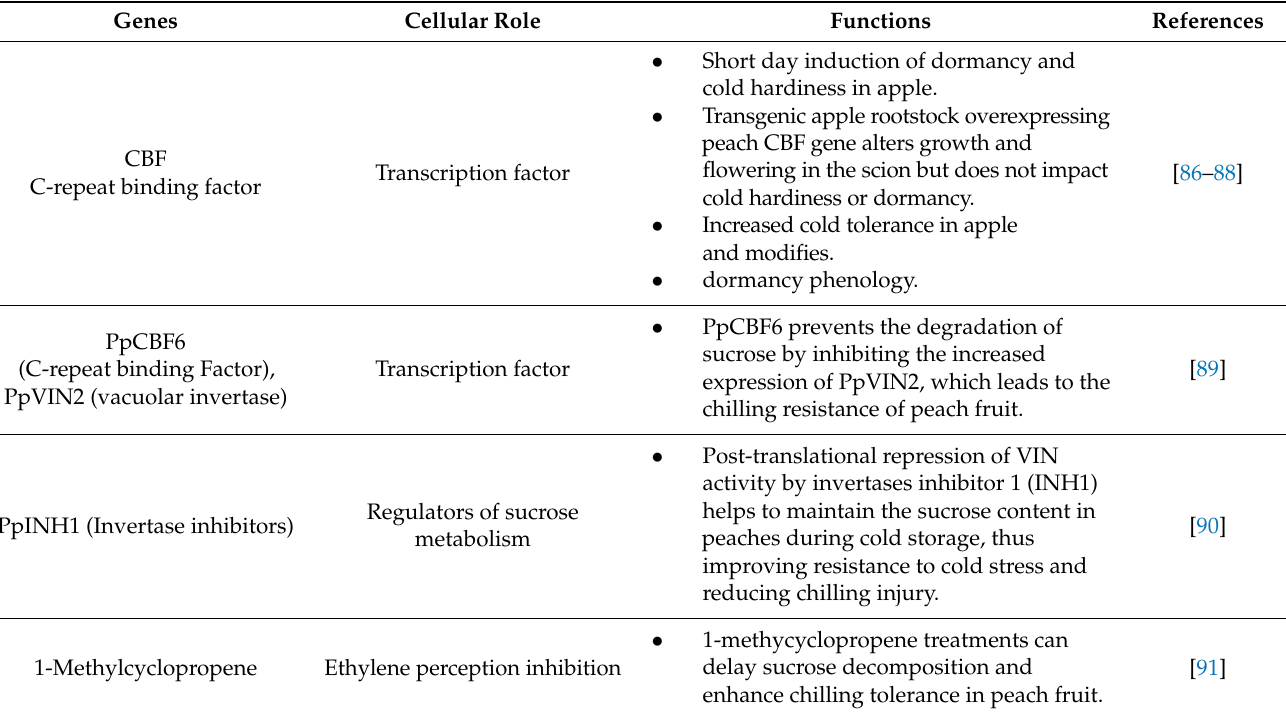
Table 1. Freeze tolerance in P. persica